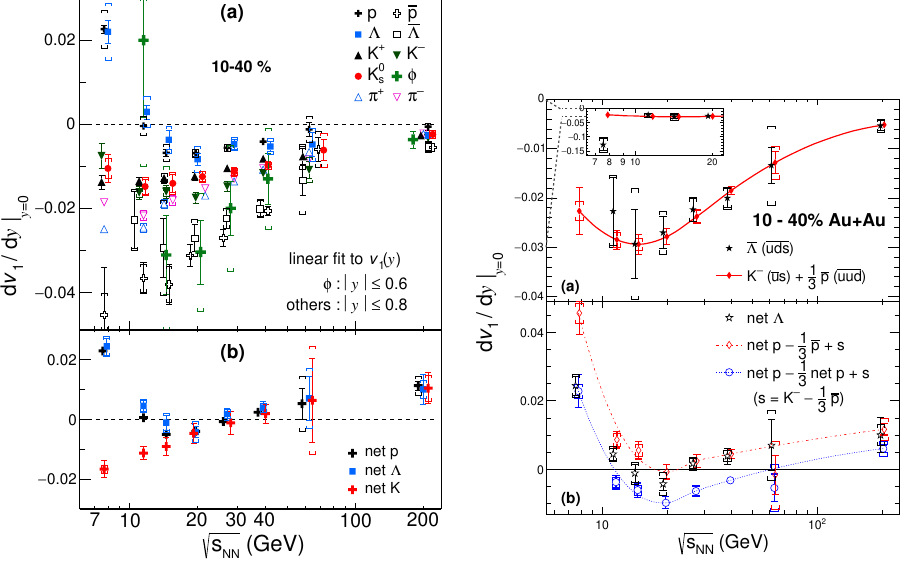
Figure 1. (Left) Directed flow slope ( d v 1 / d y ) versus beam energy for midcentral (10-40%) Au + Au collisions. Panel (a) presents (anti)protons, (anti)Lambdas, φ meson, and kaons. Panel (b) shows net protons, net Λ s and net kaons. (Right) Directed flow slope ( d v 1 / d y ) versus 40%) collisions. Panel (a) compares the observed ¯ Λ slope with the expectation from the coalescence sum rule for produced quarks. Panel (b) shows test of the coalescence sum rule for net- Λ